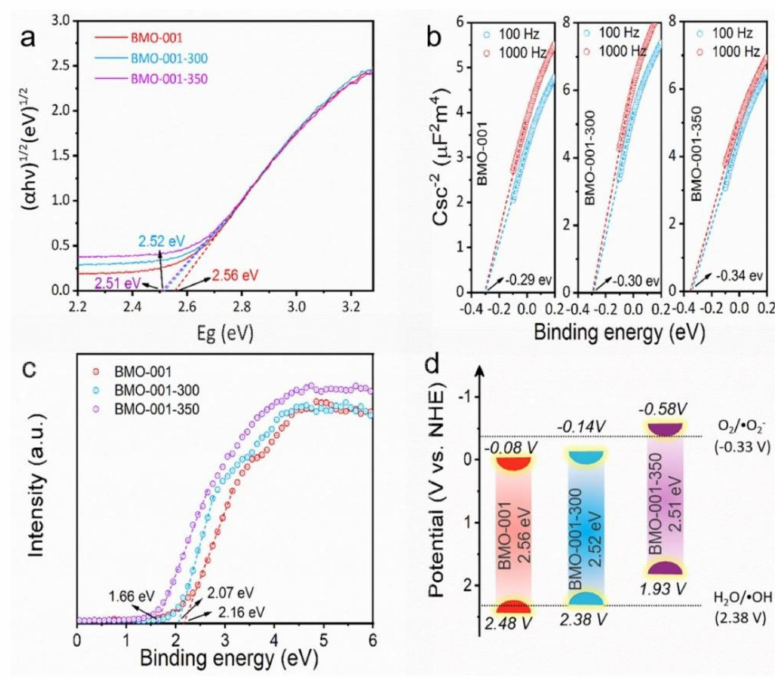
Figure 6. The plots of ( α h ν ) 1/2 versus photon energy (h ν ) ( a ), Mott–Schottky plots ( b ), VB-XPS ( c ) and a schematic illustration of the band structure ( d ) of BMO-001, BMO-001-300 and